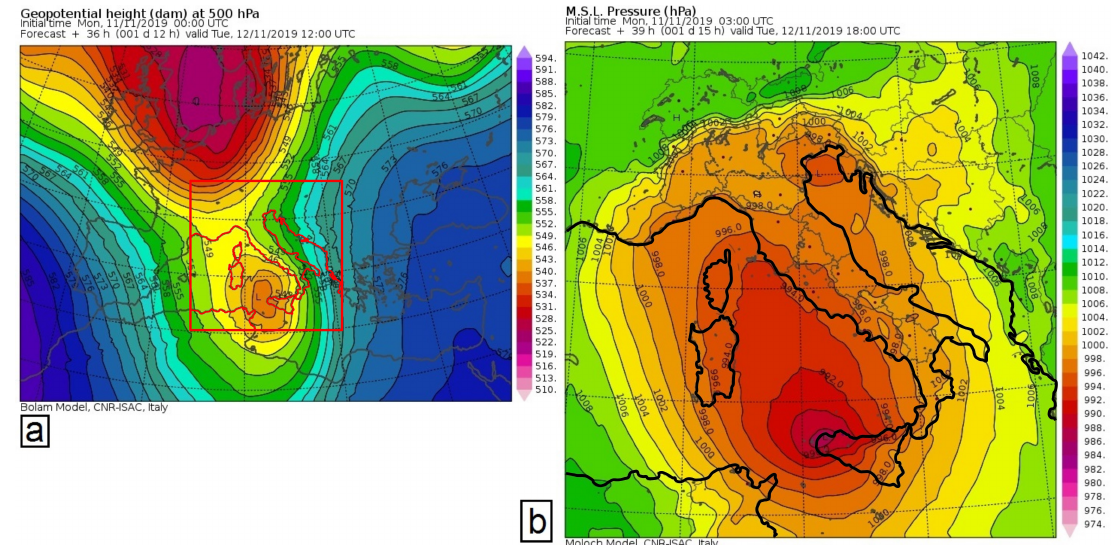
Figure 2. ( a ) Geopotential height at 500 hPa over the western Mediterranean Sea at 12.00 UTC on 12 November 2019; ( b ) surface pressure over the central Mediterranean at 18.00 UTC on 12 November 2019. Notice also the secondary minimum over the northern Adriatic. Images downloaded from [32]; the coastline is